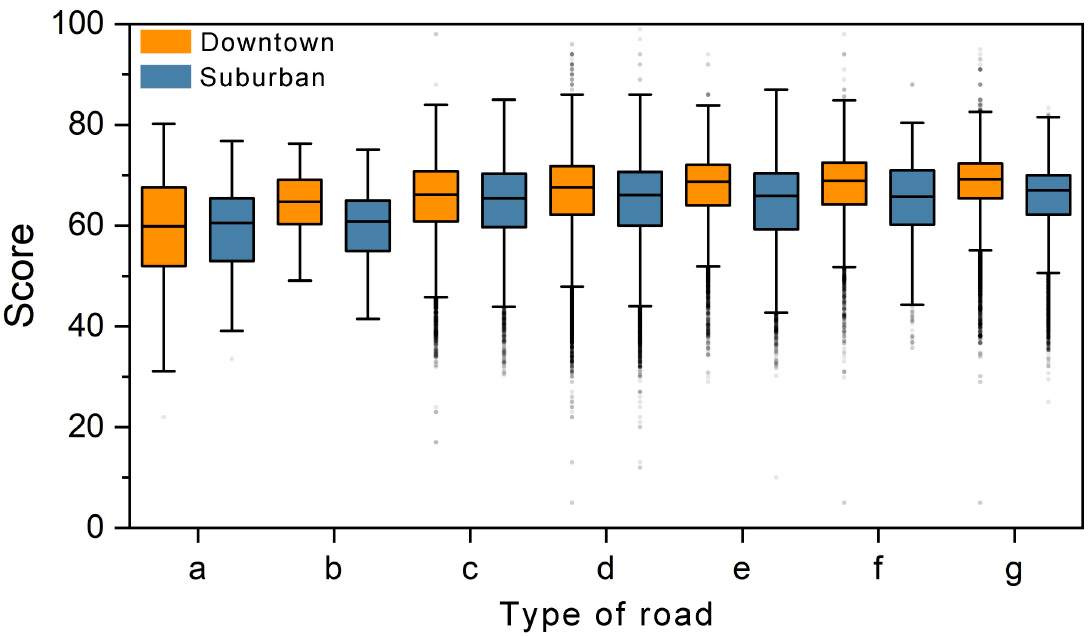
Figure 9. Safety scores for different types of roads between downtown and suburban: (a) rural roads, (b) cycle paths, (c) internal roads, (d) urban feeder roads, (e) urban secondary roads, (f) footpaths, and (g) urban main roads.